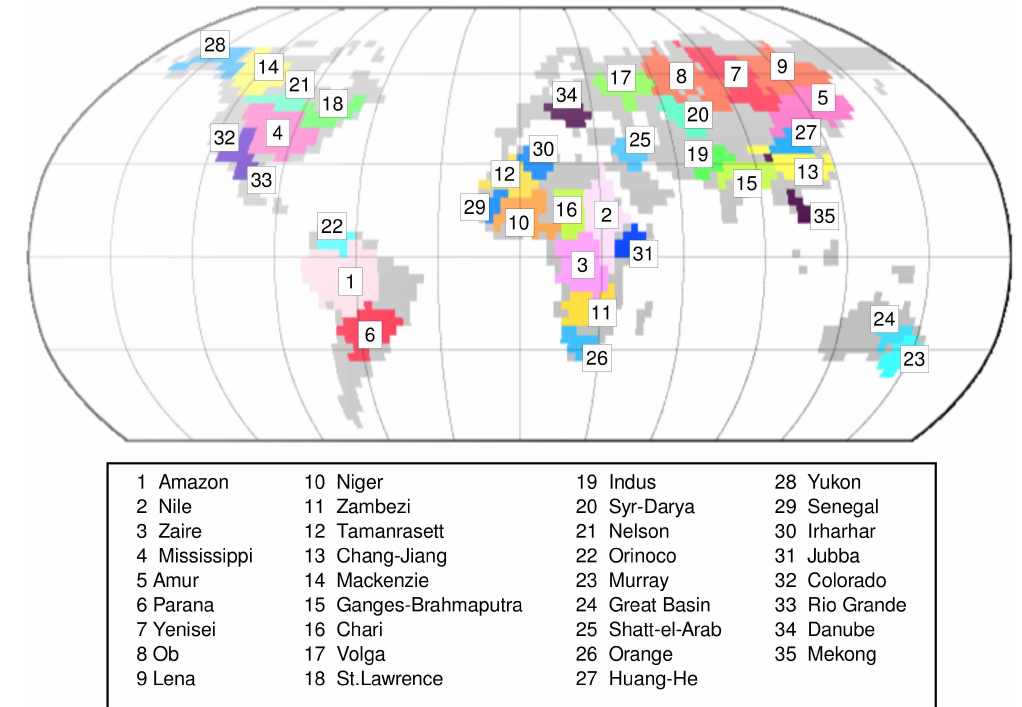
Fig. A1. Overview of the 35 largest catchments by area of the world. Fig. B1. Overview of the 35 largest catchments by area of the world.